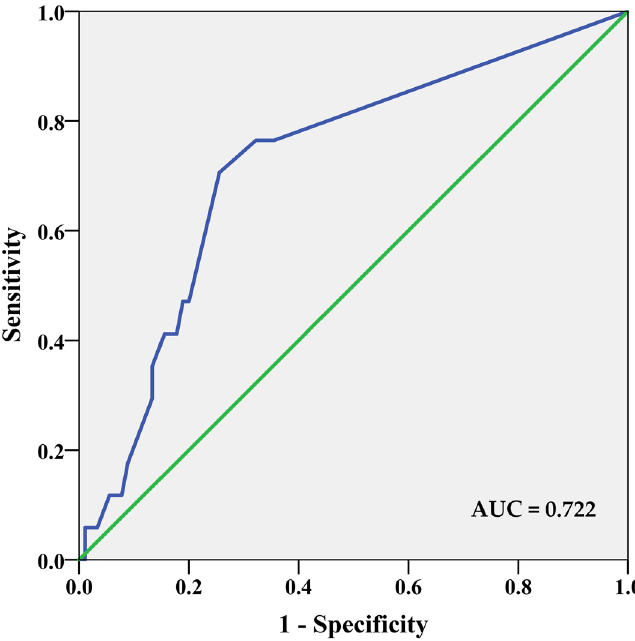
Figure 6. The area under a curve (AUC) of receiver operating characteristic (ROC) analysis for PD-L1 expression in tumour based on IHC data. ROC analysis revealed that low circulating VEGF, IL-15, and TNF-β levels (all three below the median vs. all other combinations) has significant sensitivity and specificity to discriminate between patients with low and high PD-L1 expression in tumours. The area under the curve (AUC) value of 0.722 (95% CI 0.59–0.85; P =